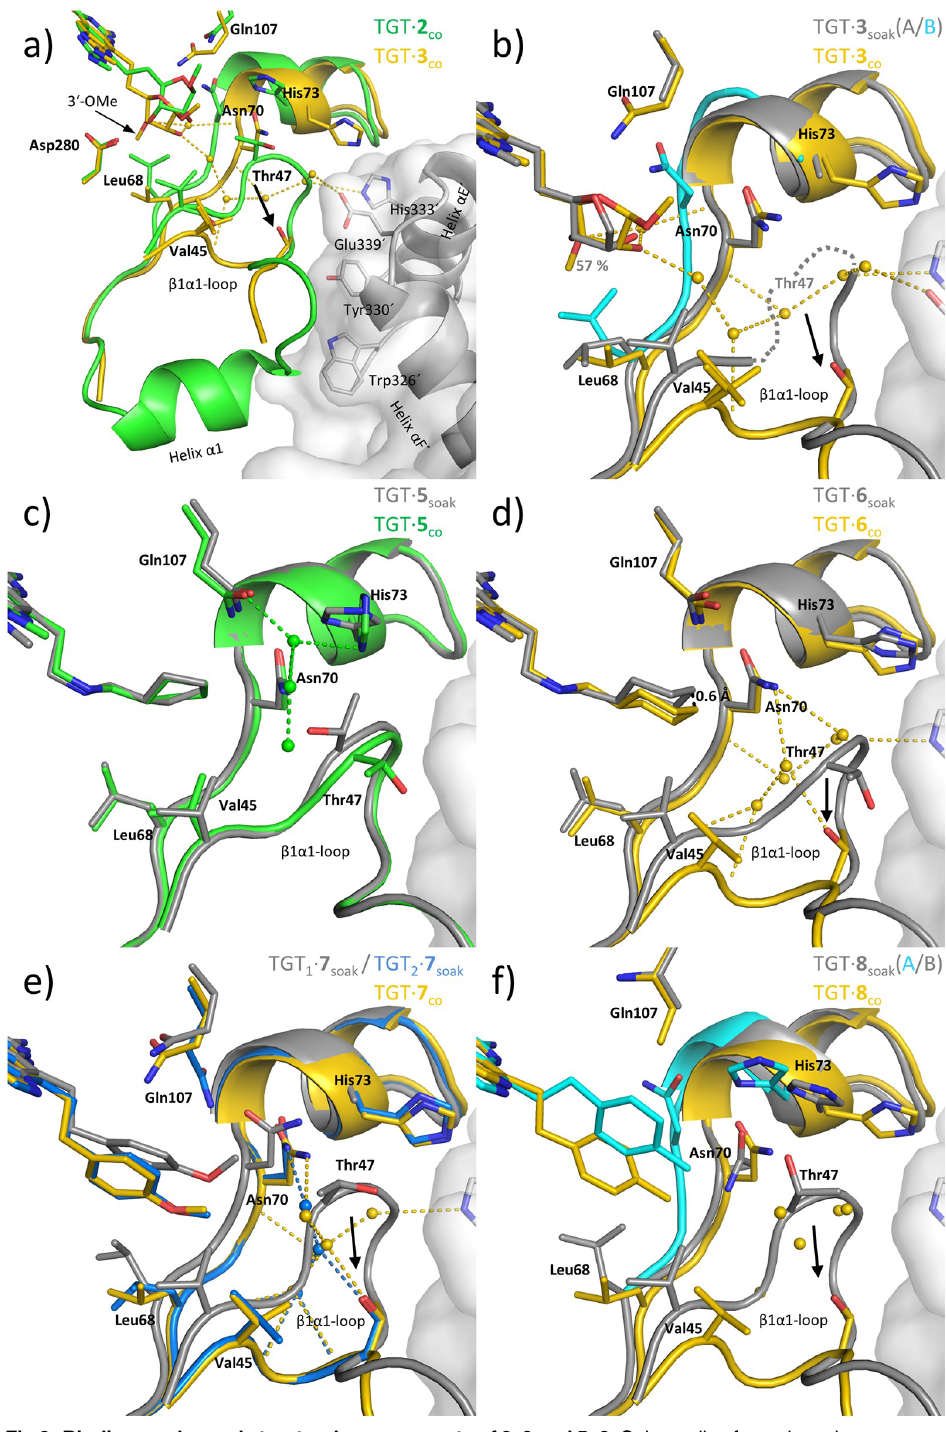
Fig 3. Binding modes and structural arrangements of 2, 3 and 5–8. Color coding for carbonsin parenthesis. Comparison of a) TGT (cid:1) 2 co (green)and TGT (cid:1) 3 co (yellow), b) TGT (cid:1) 3 soak (conformation B cyan and conformation A gray) and TGT (cid:1) 3 co (yellow), c) TGT (cid:1) 5 soak (gray) and TGT (cid:1) 5 co (green), d) TGT (cid:1) 6 soak (gray) and TGT (cid:1) 6 co (yellow), e) TGT (cid:1) 7 soak (TGT 1 gray; TGT 2 blue) and TGT (cid:1) 7 co (yellow), f) TGT (cid:1) 8 soak (conformation A: cyan and conformation B gray) and TGT (cid:1) 8 co (yellow). Selectedwater moleculesare shown as spheresand colored as the corresponding complex. For the sake of clarity, residuesof the guanine-34/preQ 1 bindingsite